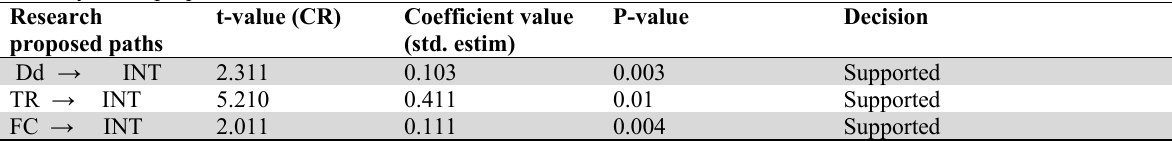
Summary of the proposed results for the theoretical model Research proposed